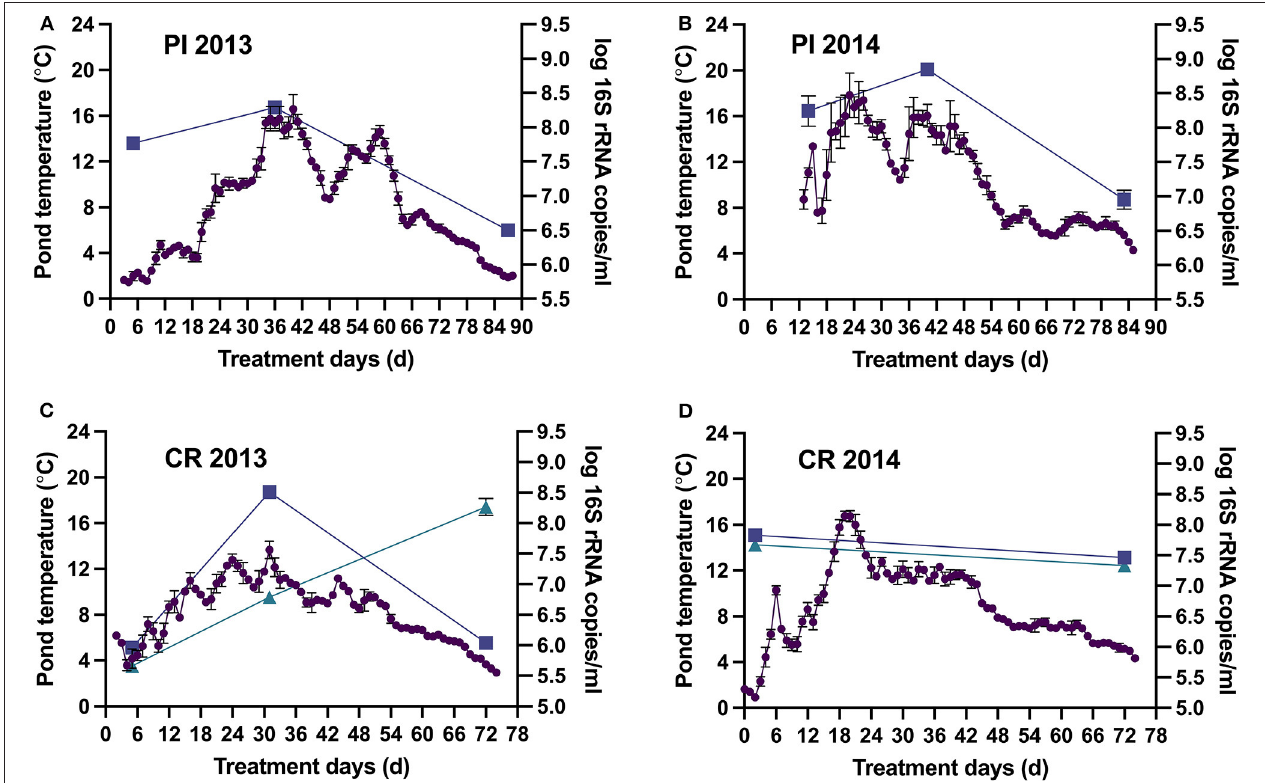
FIGURE 1 | Pond Inlet (PI) and the Clyde River (CR) WSP system surface pond temperatures ( • ) and bacterial populations [log 16S rRNA copies/mL, (cid:4) primary pond, N secondary pond (only CR), mean ± standard deviation] during the 2013 (A,C) and 2014 (B,D) treatment seasons. Bacterial populations were determined at the beginning, middle, and end of treatment seasons. Temperatures are represented by daily averages of hourly measurements ( n = 24, mean ± standard deviation) from the deployed